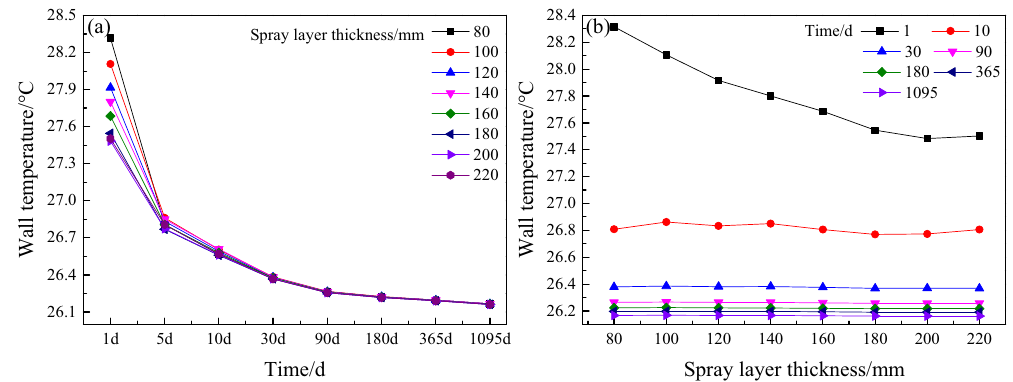
Figure 20: Influence of spray layer thickness on wall temperature: ( a ) wall temperature change with time; ( b ) wall temperature change with the spray layer